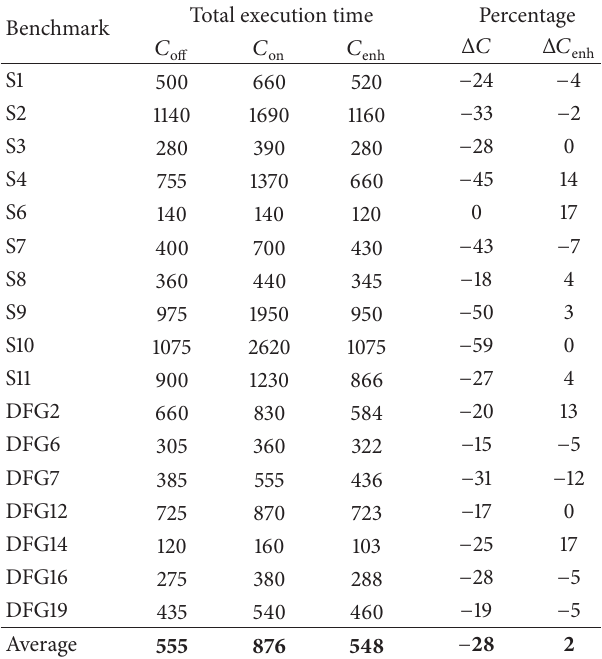
Table 3: Schedulers comparison for total execution time (after learning